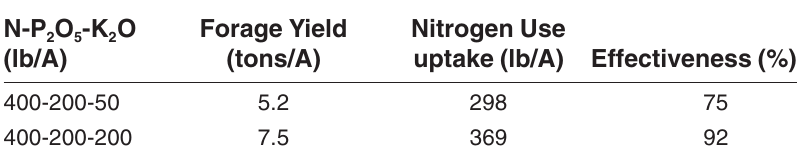
Influence of K on N-Use Effectiveness of Coastal Bermudagrass[8]